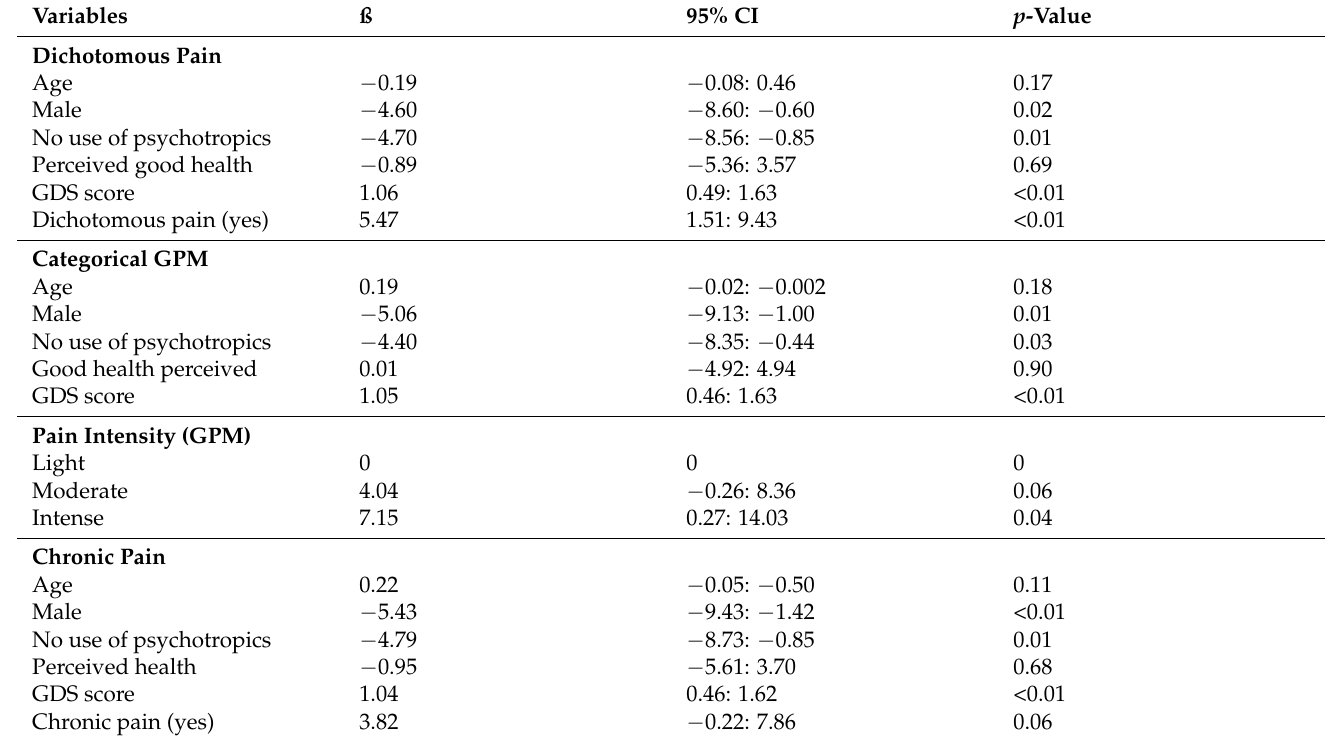
Table 5. Multivariate Analysis of the FES-I, Natal, RN, 2018. ( n =